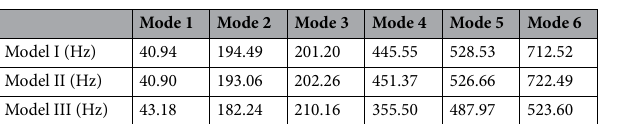
Table 4. Mode frequencies of the three finite element